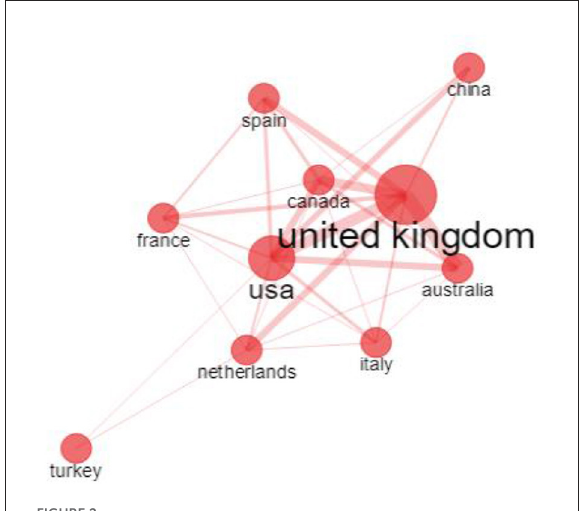
FIGURE2 Visualization map of the scientific collaboration among countries. The nodes and lines between them show the countries and their cooperative relationships, respectively. The size of the node indicates the number of publications, and the width of the line represents the strength of the